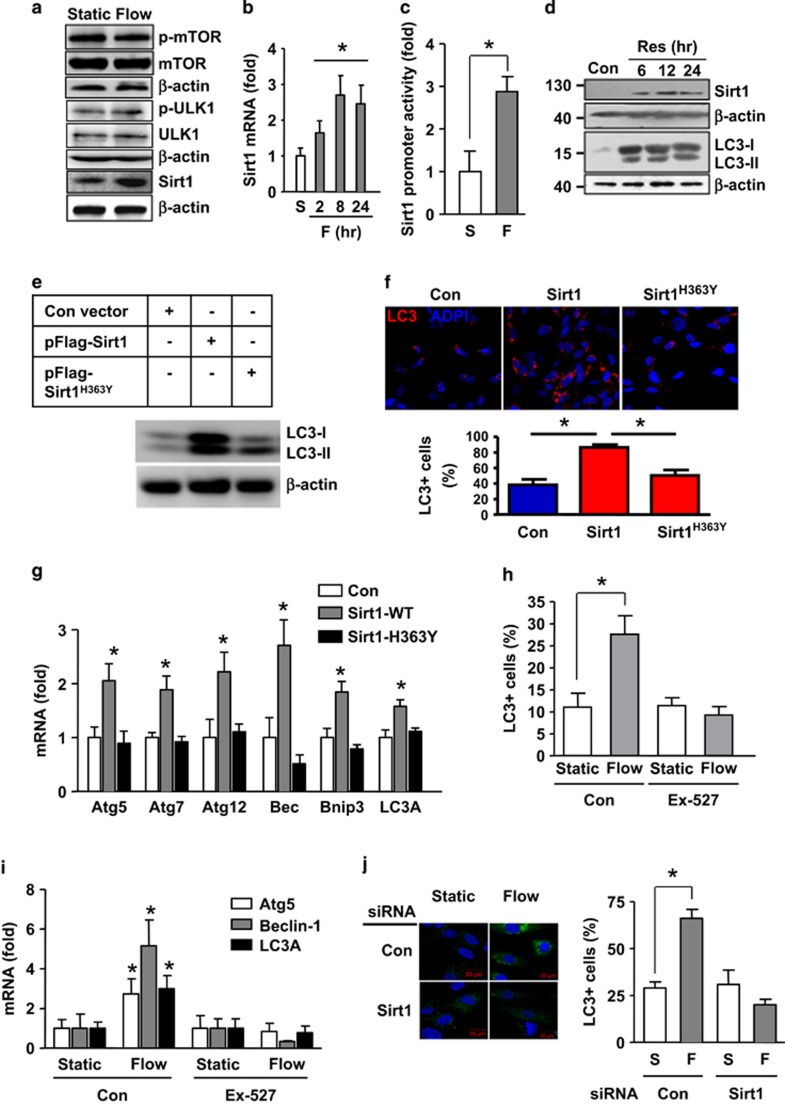
Sirt1 was critical in mediating shear stress-induced autophagy in endothelial cells. (a) Effects of laminar flow on the phosphorylation levels of mTOR and ULK1, and the expression level of Sirt1 (representative images from four experiments). (b) Time course of the effect of laminar flow on the mRNA expression of Sirt1. (c) Effect of laminar flow on the promoter activity of human Sirt1 as measured by luciferase reporter assay. (d) Effects of the Sirt1 activator resveratrol (10 μM) on the protein levels of Sirt1 and LC3. (e) Effects of overexpression of Flag-tagged wild-type Sirt1 and Sirt1-H363Y mutant on LC3 expression. (f) Effects of Sirt1 and Sirt1-H363Y overexpression on accumulation of LC3 puncta. (g) Effects of wild-type Sirt1 and Sirt1-H363Y overexpression on the mRNA expression levels of various autophagy-related genes as indicated. (h) Effects of the Sirt1 inhibitor EX-527 (10 μM) on flow-induced autophagy. (i) Effects of EX-527 on flow-induced upregulation of Atg5, beclin-1, and LC3A. (j) Effects of Sirt1 gene silencing with siRNA on flow-induced LC3 puncta accumulation. Data are mean±S.E.M. *P<0.05, unpaired t-test or one-way analysis of variance, n=3–4. Res, resveratrol